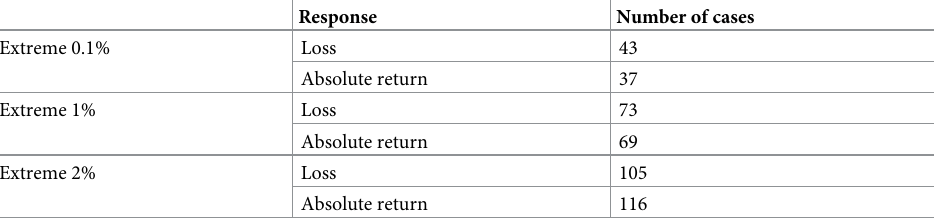
Table 3. The number of trading days out of 3333 days for which we accept the predictions in the RMSE assess- ments with extremes of 0.1%, 1%, and 2% in Eq (12). The rows indicate the responses (loss and absolute return) to predict.